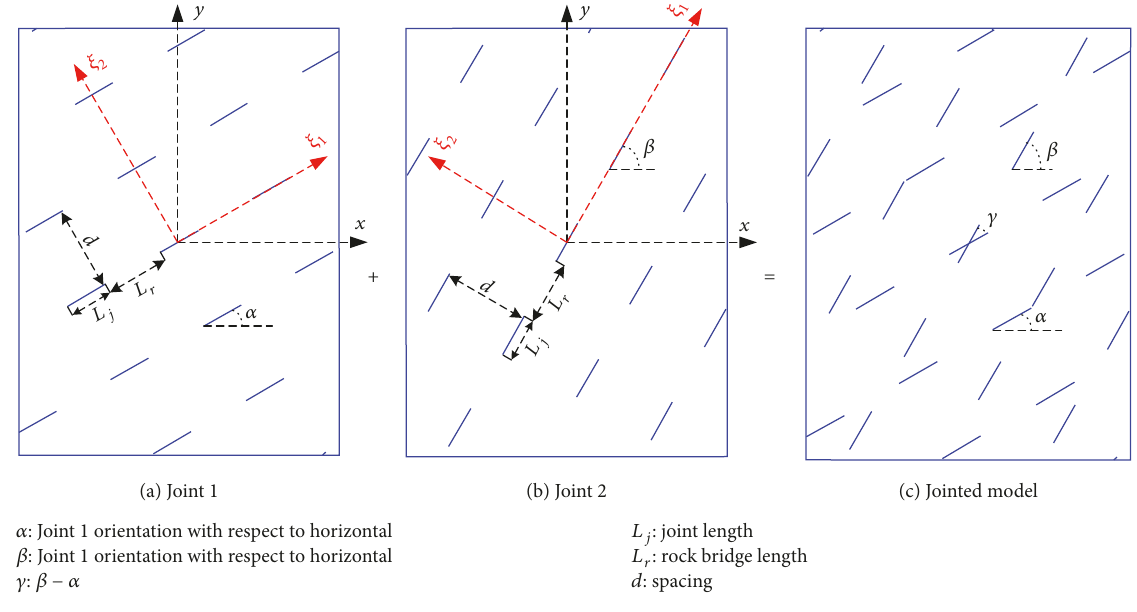
Figure 1: Schematics of fissure geometry configurations in the